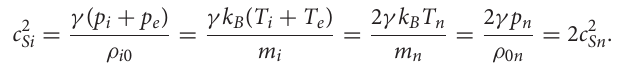
magnetic field lines, increasing their inertia, eventually causing the attenuation of Alfvén